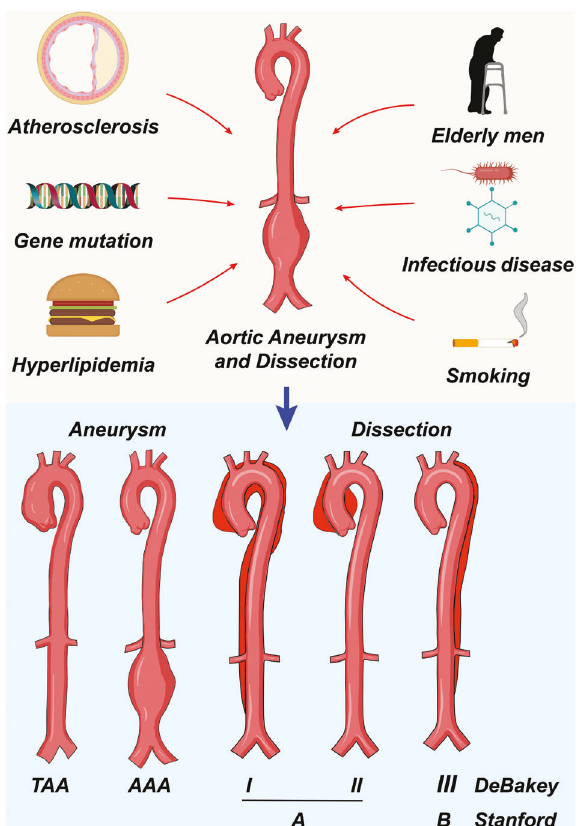
Fig. 1 The risk factors for AA formation and the classi fi cation of aortic aneurysm and aortic